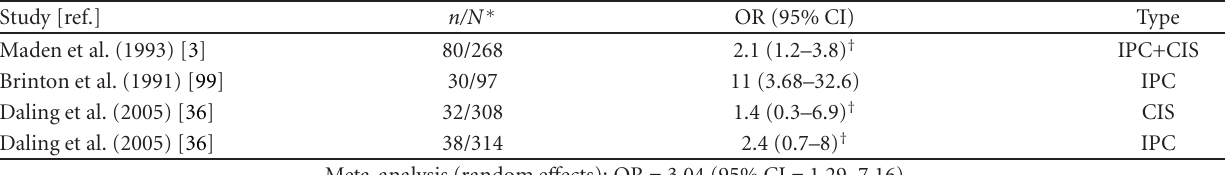
Table 3: Association between smegma and penile